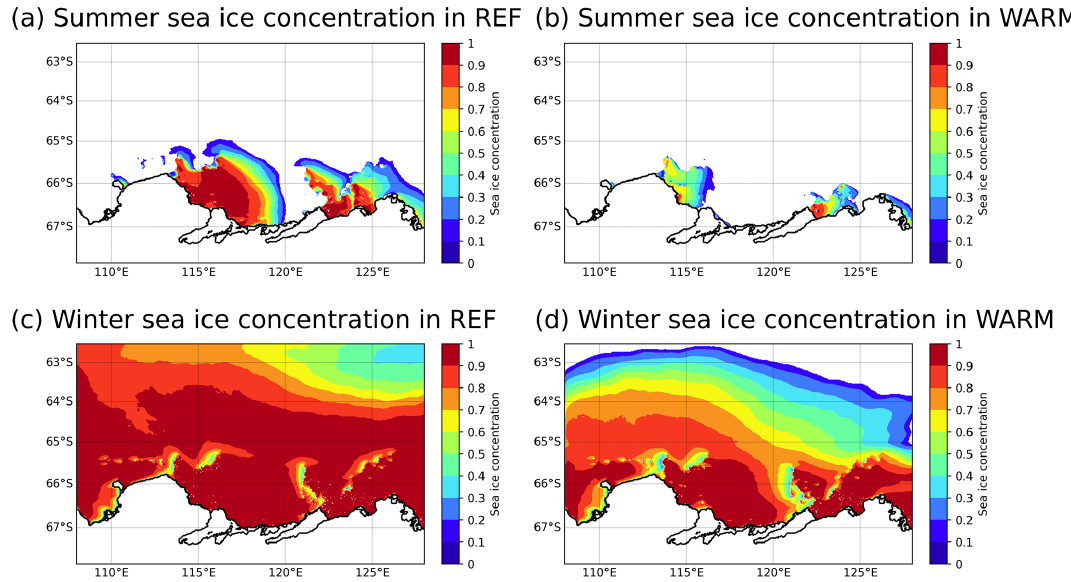
Figure 5. Sea ice concentration in summer (January–March: JFM) and winter (July–October: JASO) for the REF (a, c) and WARM (b, d) simulations, both averaged over the 20 years of simulation. The 0.75 fast ice frequency is shown by the gray line in the winter sea ice concentration